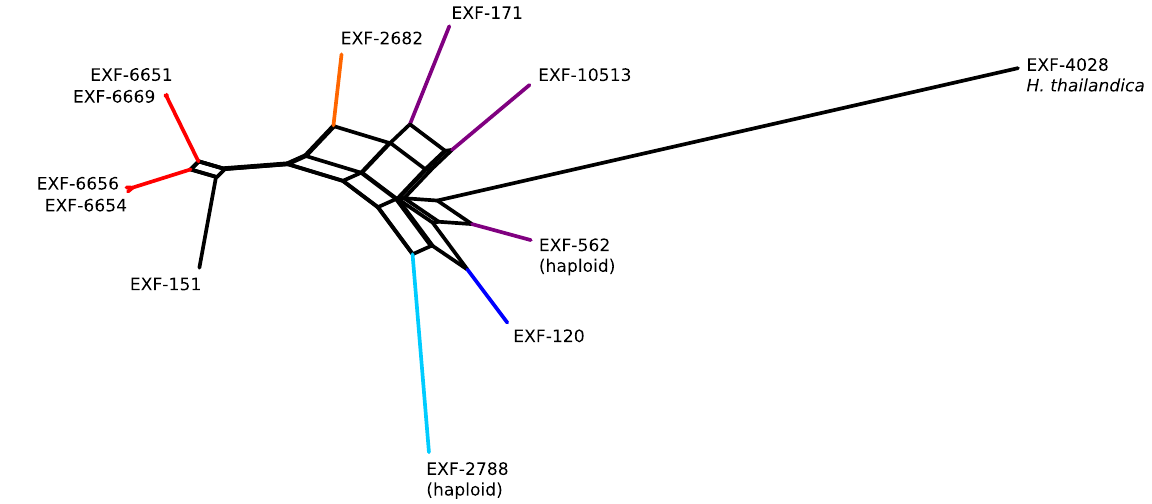
Fig. 5 Phylogenetic network of the Hortaea werneckii strains with sequenced genomes. The network was reconstructed with the Neighbour-Net algorithm based on the dissimilarity distance matrix calculated from the single nucleotide polymorphism